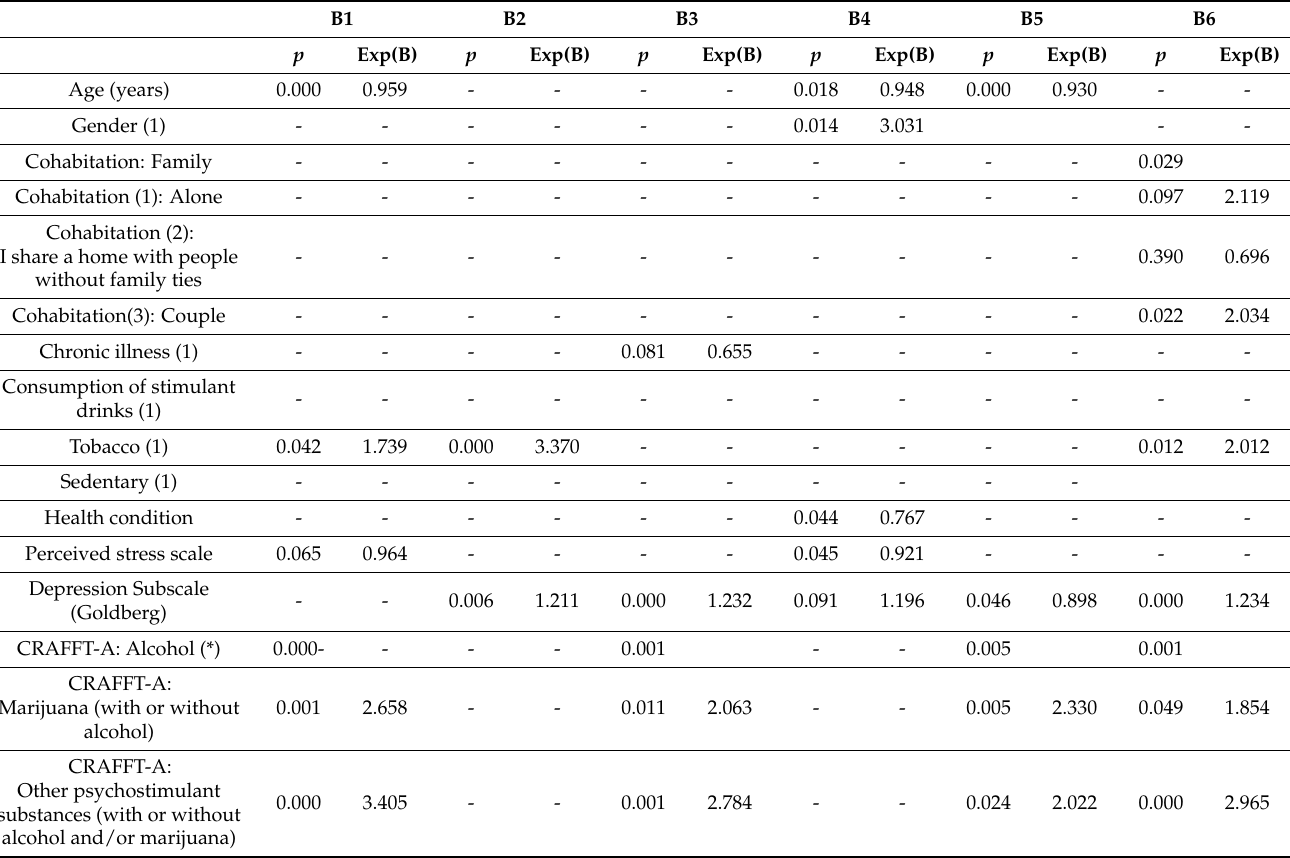
Table 9. Final logistic regression model: Variables associated with consequences of